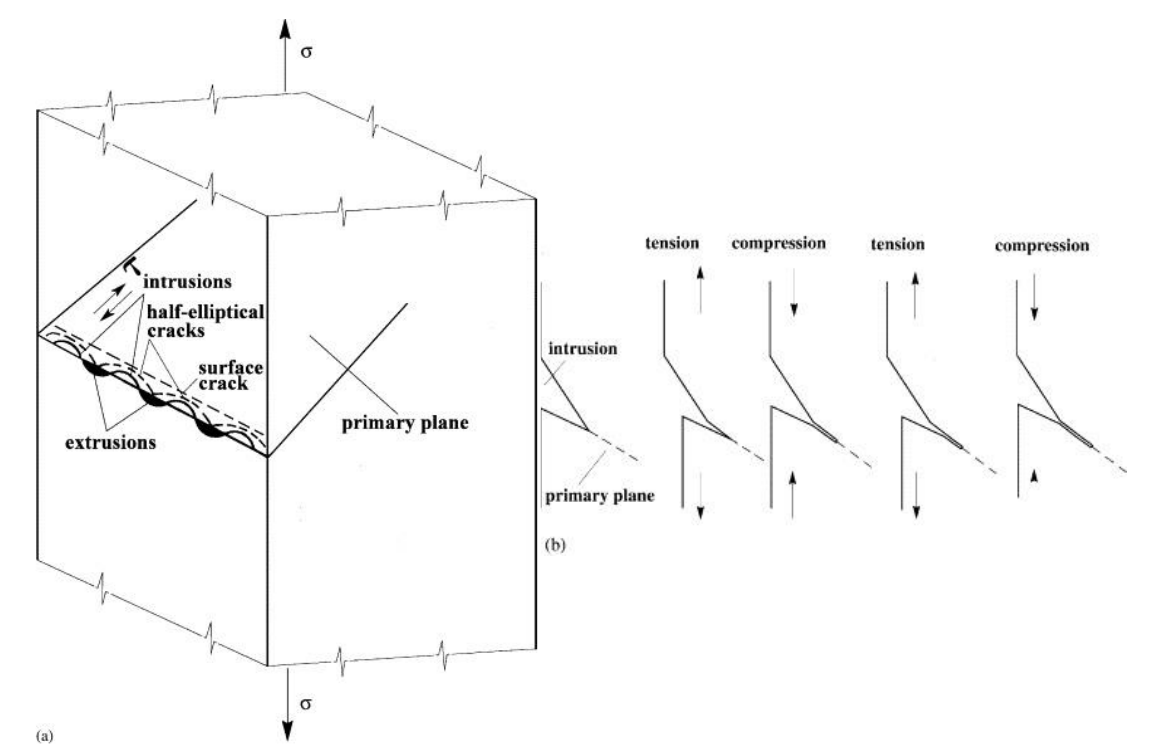
Figure 17. Schematic of crack initiation and early growth; ( a ) initiation from the row of half-elliptic intrusions, ( b ) initiation from the intrusion and early growth by slip-unslip mechanism.